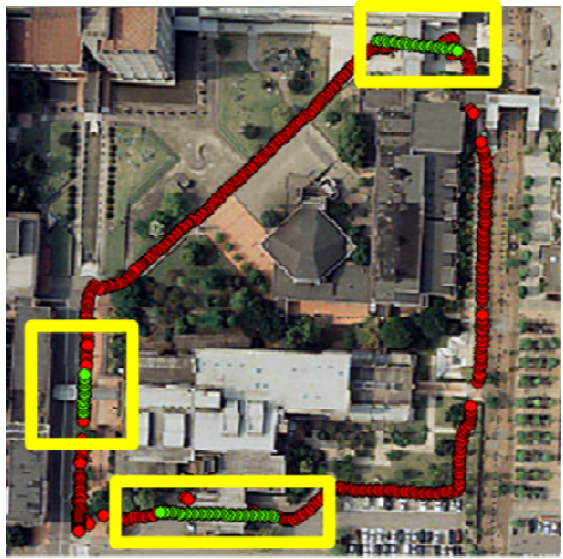
Figure 3. Overlapping display of experimental